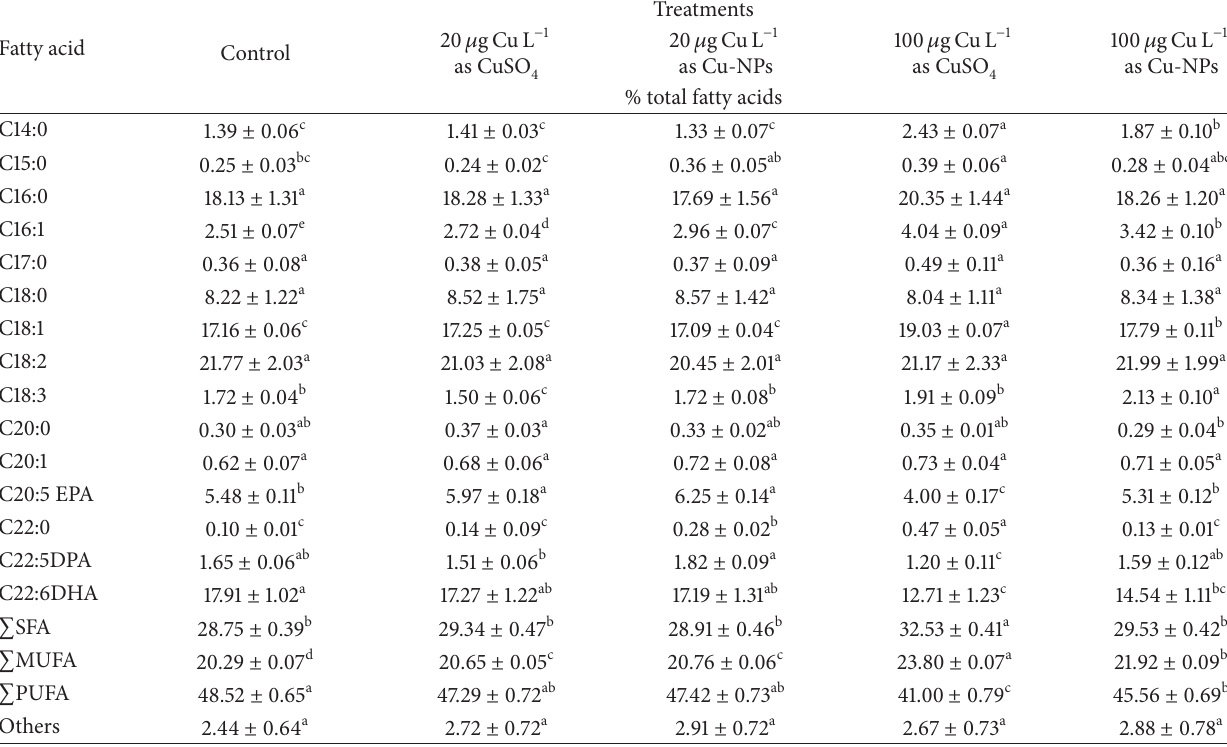
Table 3: Effects of Cu-NPs and CuSO on whole-body fatty acid composition of juvenile Epinephelus coioides after 25 days exposure. 4